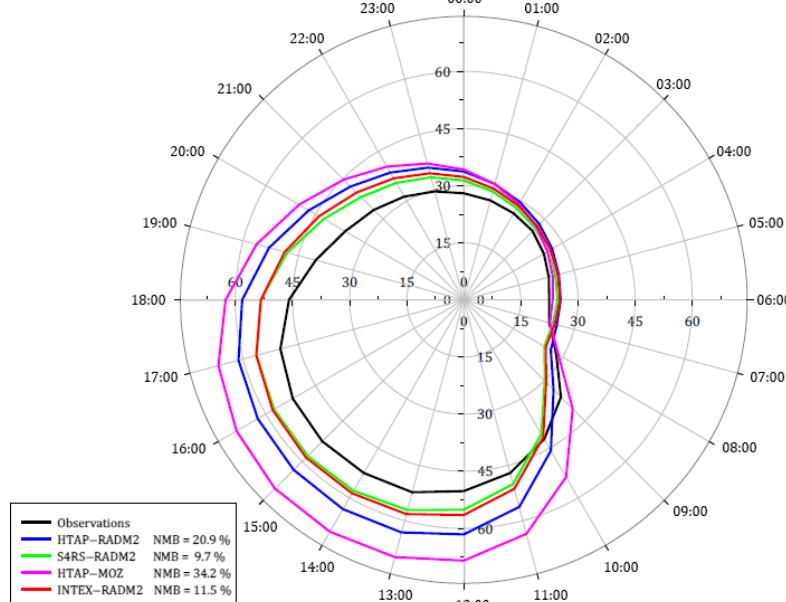
Figure 14. Polar plot for monthly mean diurnal variation of surface ozone (in ppbv) from all model simulations and observations, each spatially averaged over all sites. The numbers on the outermost circle represent the hour of the day, and the radial distance from the centre represents surface ozone mixing ratios in ppbv. The normalized mean biases (NMBs in %) for noontime surface ozone are indicated in the caption